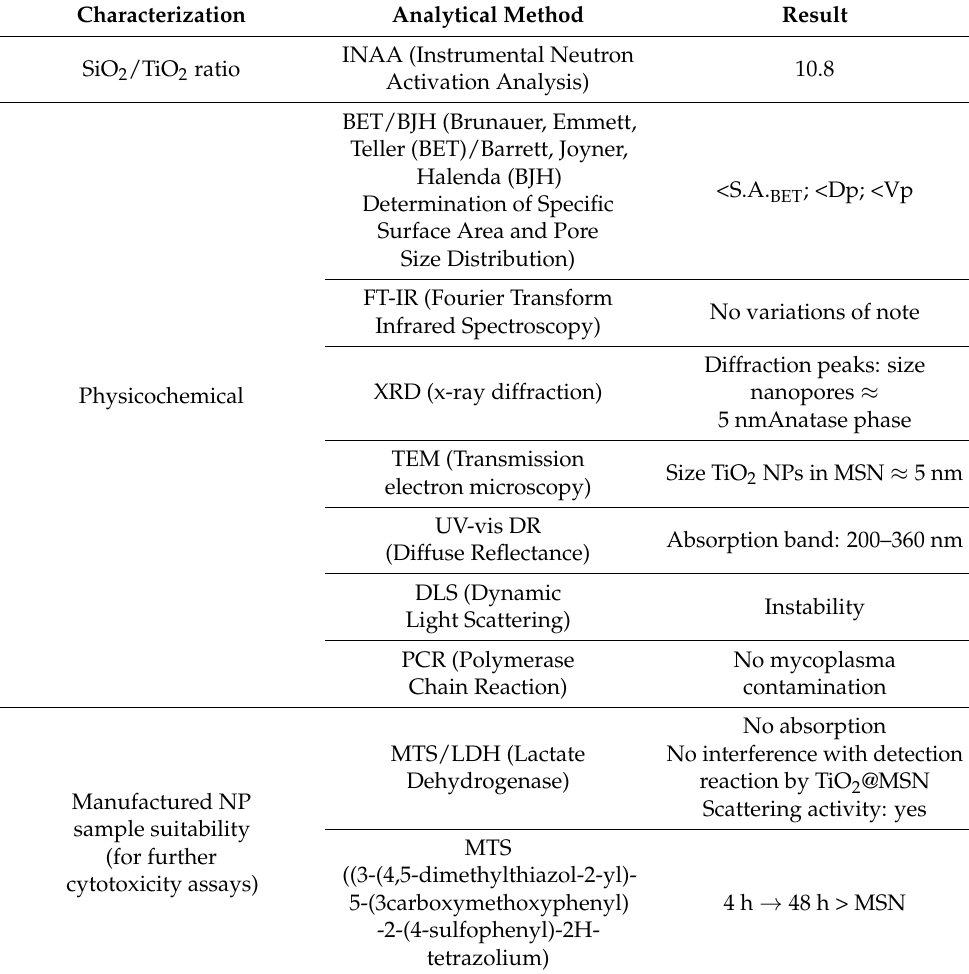
Table 1. Physicochemical characterization and evaluation of contaminants and cytotoxic activity of TiO 2